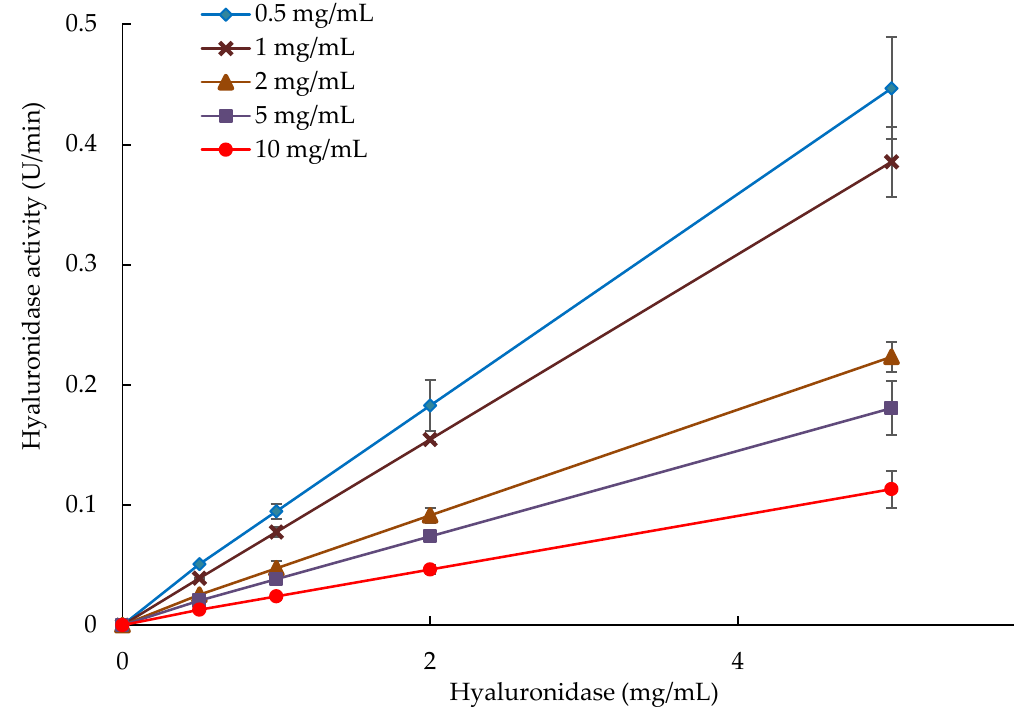
Figure 4. E ff ects of rice protein hydrolysate on the hyaluronidase activity with 5 mg / mL HA as Figure 4. Effects of rice protein hydrolysate on the hyaluronidase activity with 5 mg/mL HA as a a substrate.